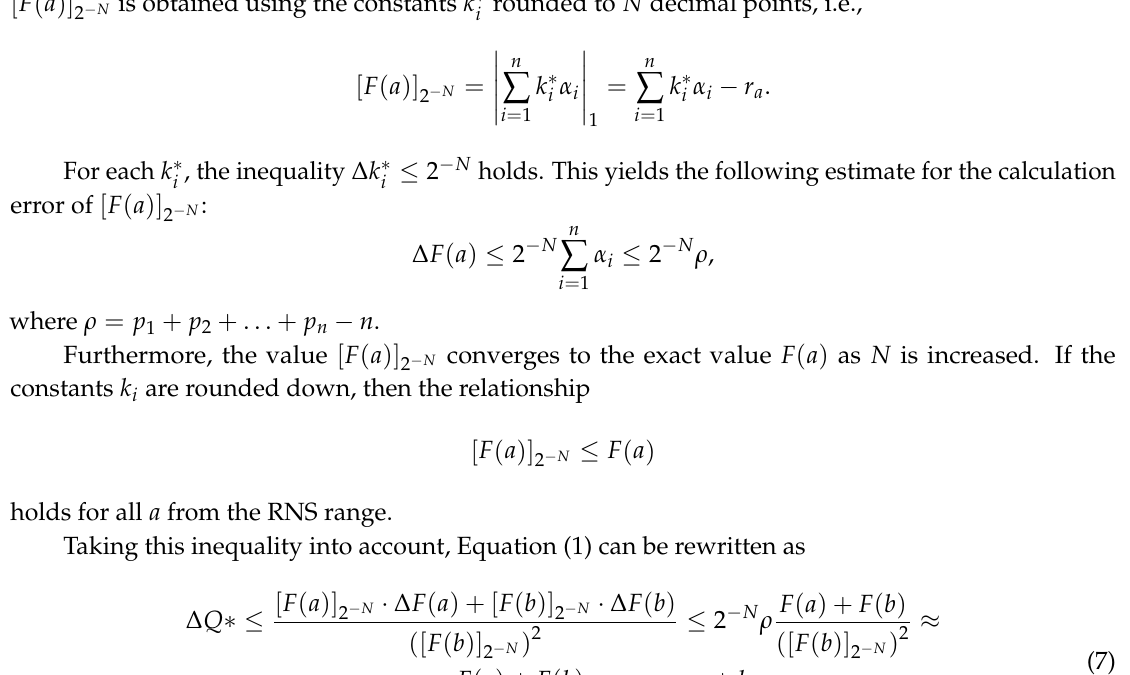
Figure 3. Relative error for approximate division of P − 1 by b with RNS moduli set {5, 7, 9, 11} and N = 17 . 14125 by new algorithm. Table 2. Calculation of